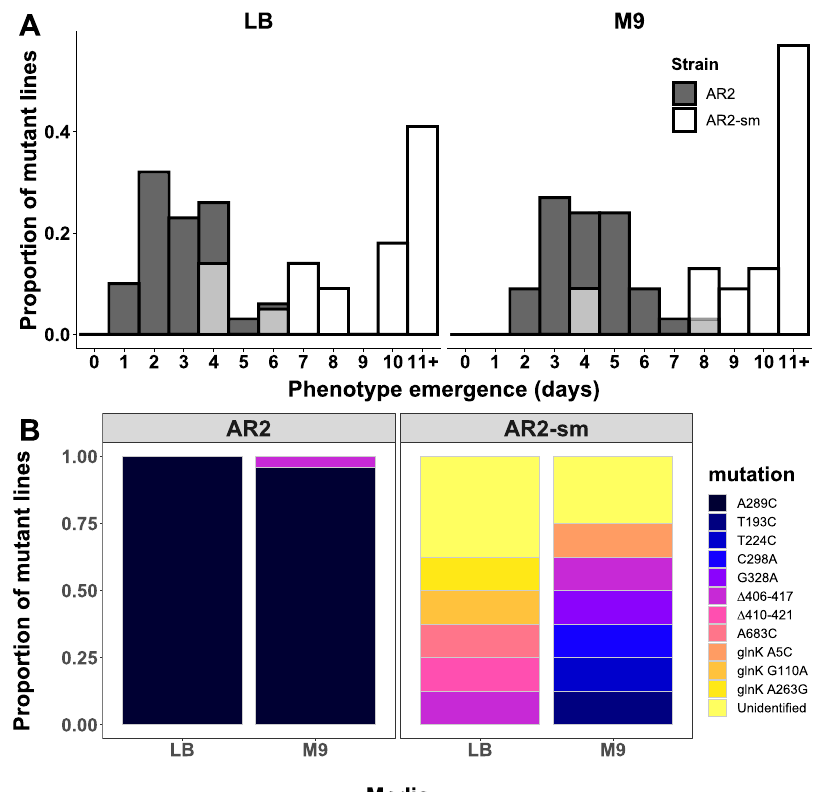
Fig. 4 A synonymous sequence mutant (AR2-sm) confers a loss of repeatable evolution. A Histogram of motility phenotype emergence times across independent replicates of immotile SBW25 (AR2, grey) and an AR2 strain with six synonymous substitutions in the ntrB locus (AR2-sm, white) in two nutrient conditions. Lines that evolved after the experiment timeframe (10 days) were pooled into bin 11 + . B Observed mutational targets following directed evolution of synonymous variants, performed across two environments. Each unique mutation is highlighted by an identi fi able colour. (Sample sizes ( N ): AR2: LB N = 5, M9 N = 24; AR2-sm: LB N = 8, M9 N = 8). Note that characterised genotypes were sampled within 8 days of experiment start date. Unidenti fi ed mutations could not be distinguished from wild type sequences of genes belonging to the nitrogen regulatory pathway (ntrB, glnK and glnA ) which were analysed by Sanger sequencing. ntrB Δ 406-417 was the only mutational target shared by both lines within the same nutritional environment. Source data are provided as a Source Data fi